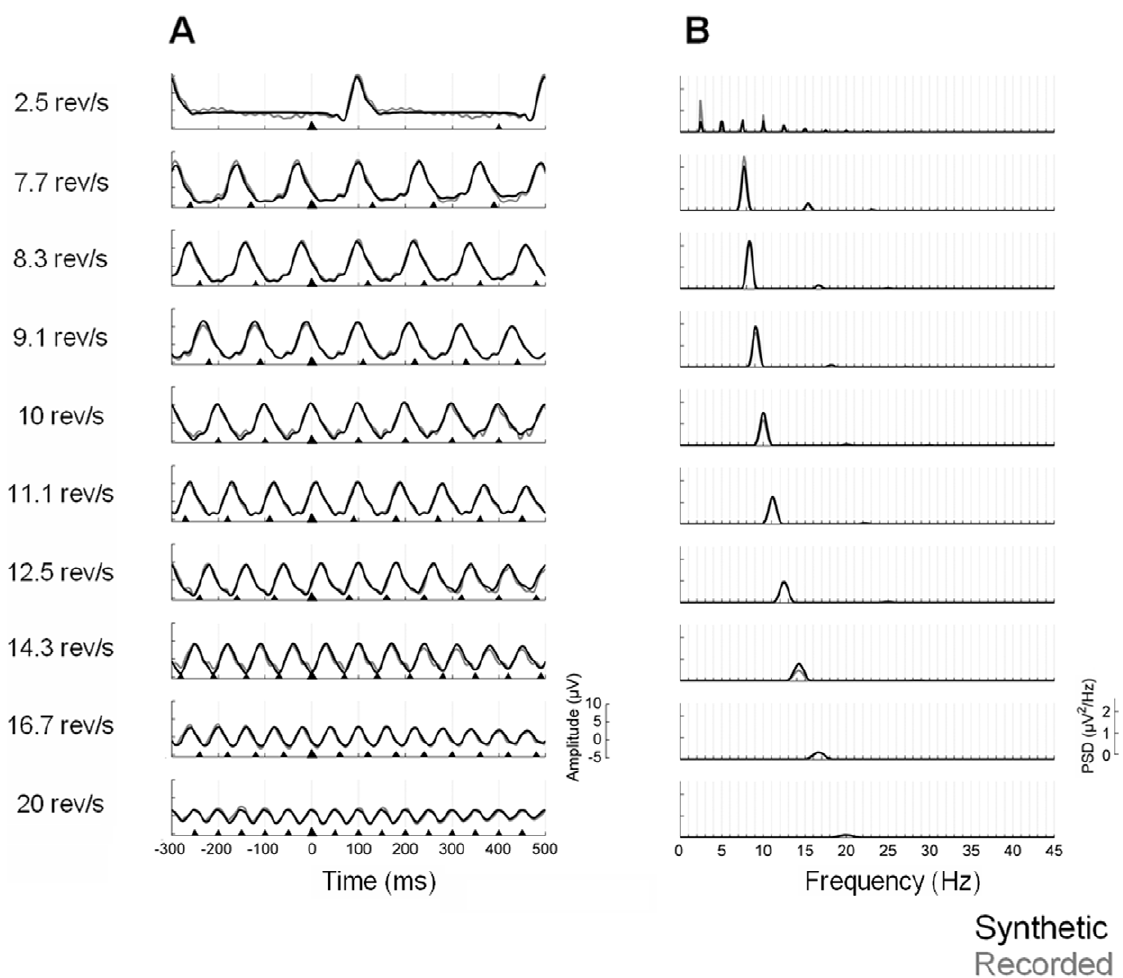
Figure 7. Synthetic waveforms obtained from linear superposition of transient templates (Experiment 2). The synthetic waveforms for the Oz lead at each stimulation rate are shown in black; the recorded data have been overlaid in grey for comparison. A , Grand-average waveforms of the synthetic data at the ten different rates studied. The triangles indicate stimuli onset; the largest triangle represents the zero time point. B , Power spectral densities of the grand-average waveforms.